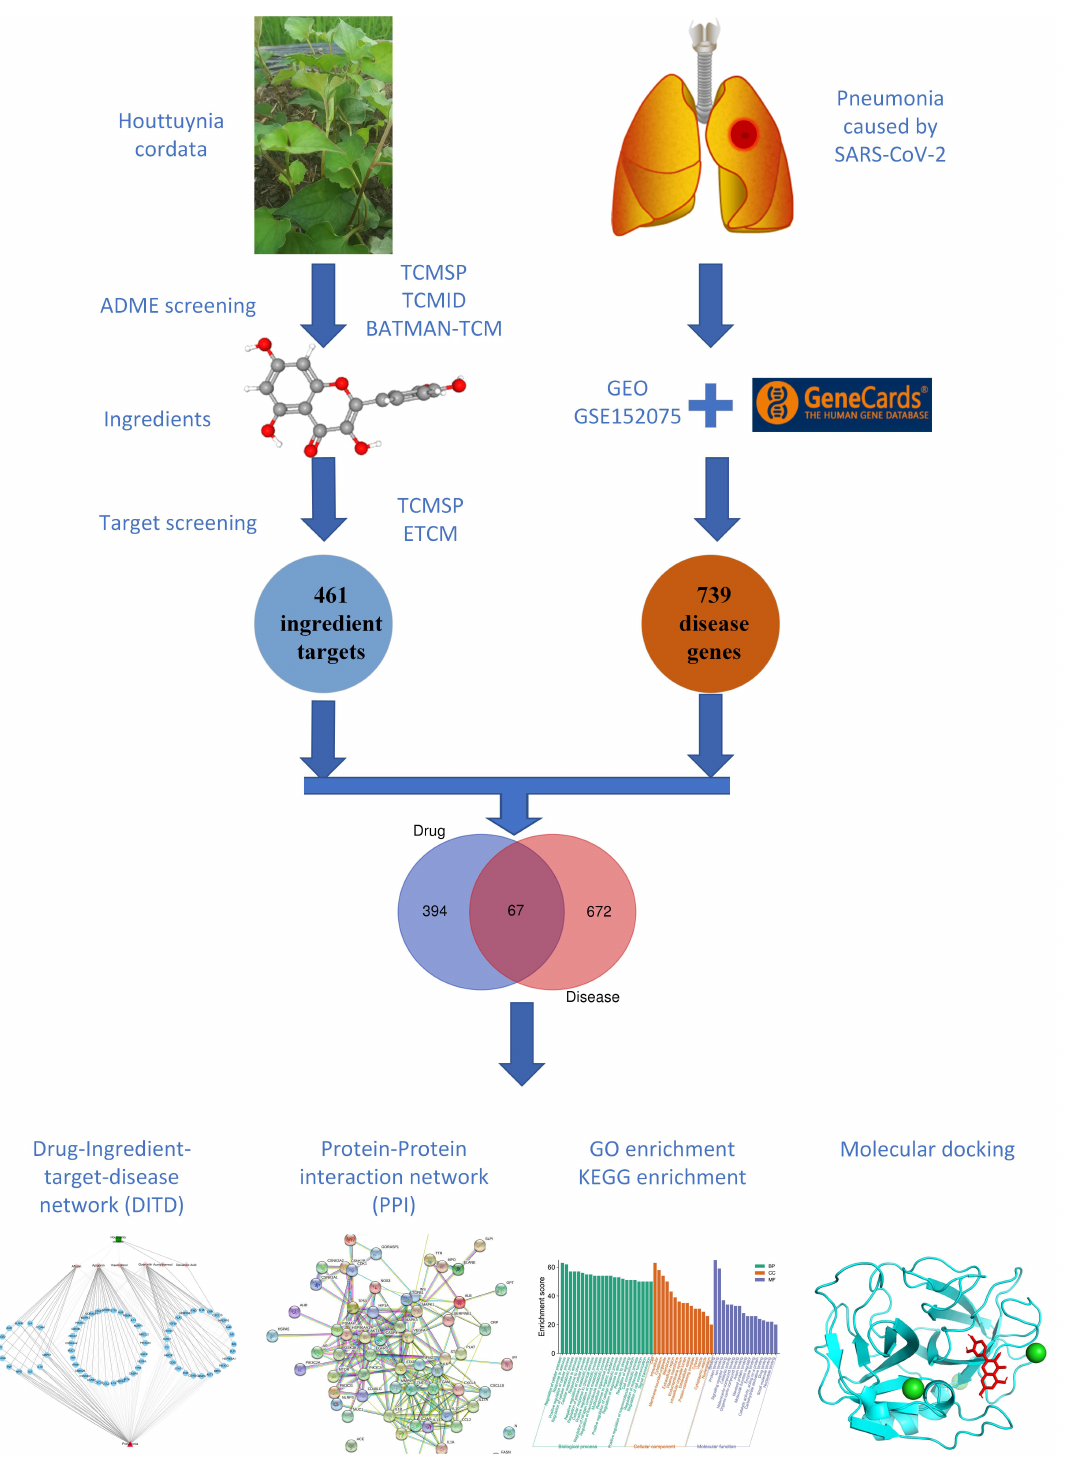
Figure 1. Framework based on an integrative strategy of network pharmacology to investigate phar- macologic mechanisms of Houttuynia cordata for the treatment of pneumonia caused by